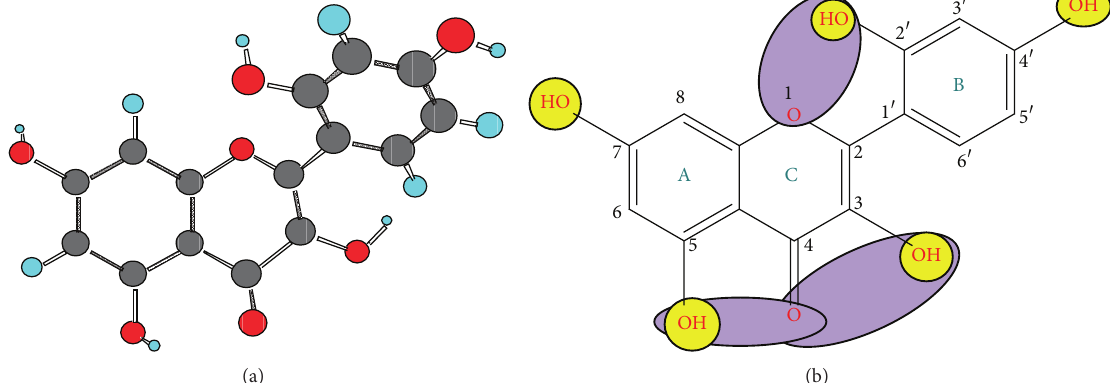
Figure1:(a)Theenergyminimizedchemicalstructureofmorin;(b)yellow-labeledfunctionalmoietiesindicatetheantioxidantactivecenters, whereas violet-labeled functions indicate its multiple chelation sites.